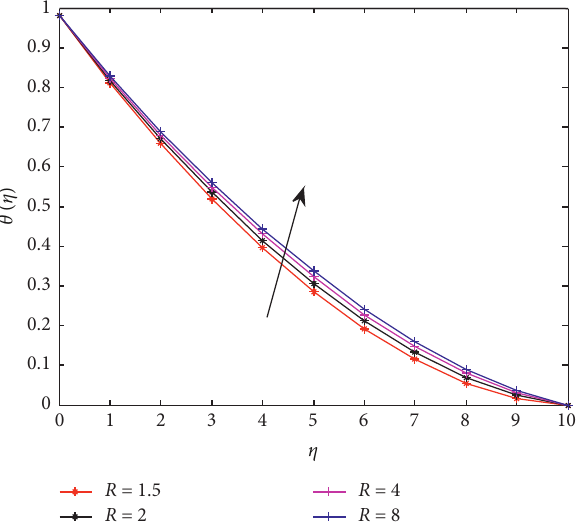
Figure 11: Alteration in temperature for various values of R when Pr � 0 . 72, β � 0 . 2, Ω � M � λ � R � s � 1, c � 0 . 2, and Ec � 0 . 1.